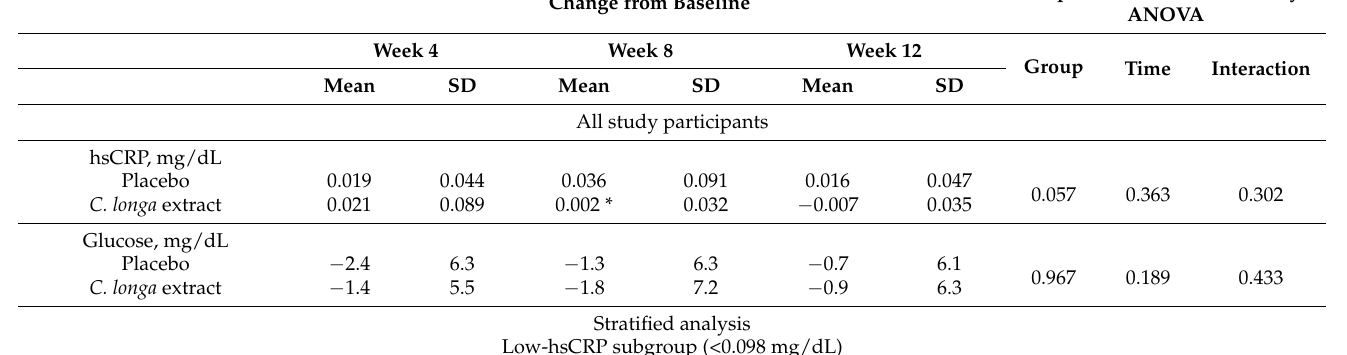
Repeated Measures Two-Way ANOVA Group Time Interaction